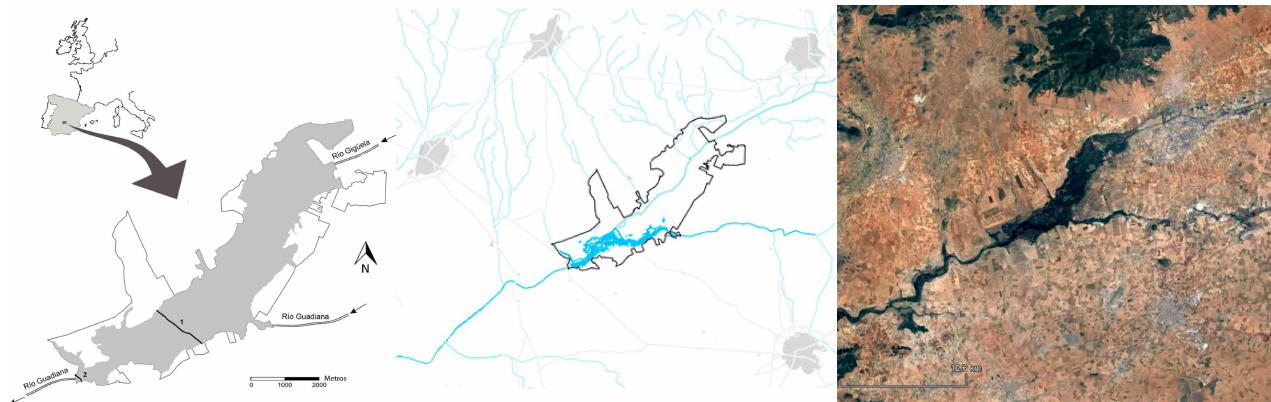
Figure 3. Tablas de Daimiel National Park: situation and boundary